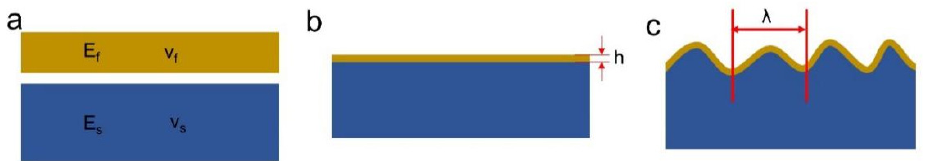
Figure 3. Schematic diagram of the plane wrinkling. ( a ) A planar double-layer hard and soft system, ( b ) the system in stretching mode and ( c ) the system in released mode.